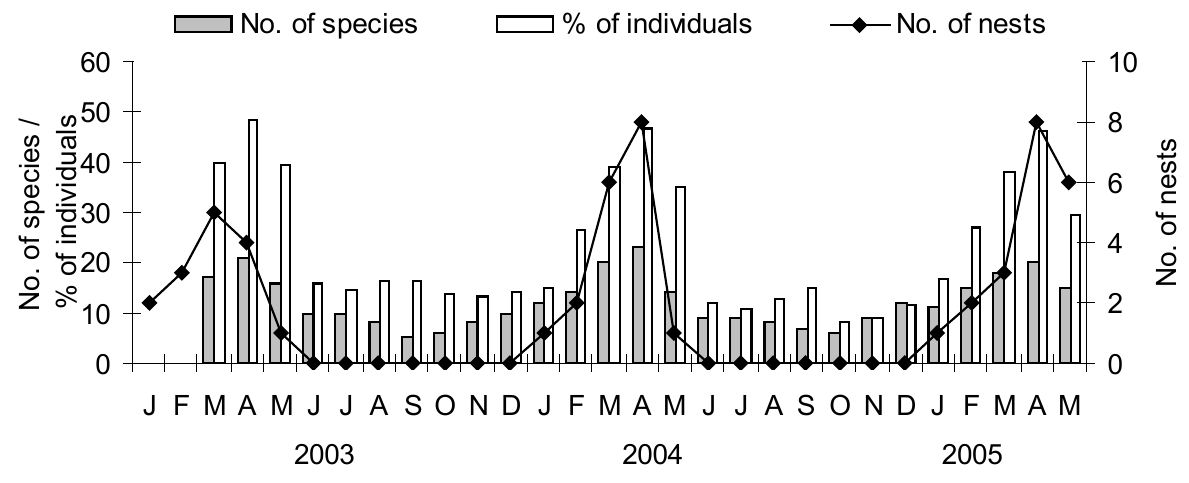
Figure 2. Relationship between breeding seasonality of Grey-headed Bulbul with the fruiting phenology of 25 major food plants at Silent Valley National Park.